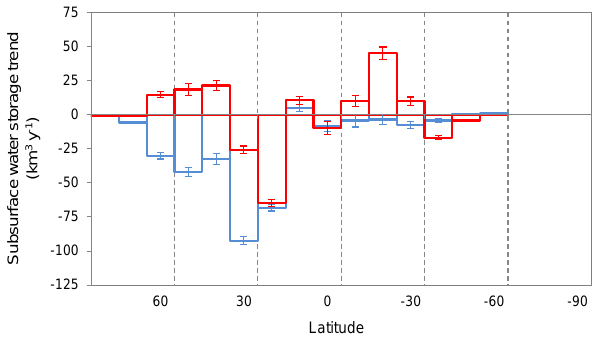
Figure 11. Linear 2003–2012 trends in subsurface water storage by 10 ◦ latitude band, showing prior (blue) and posterior (red) esti-